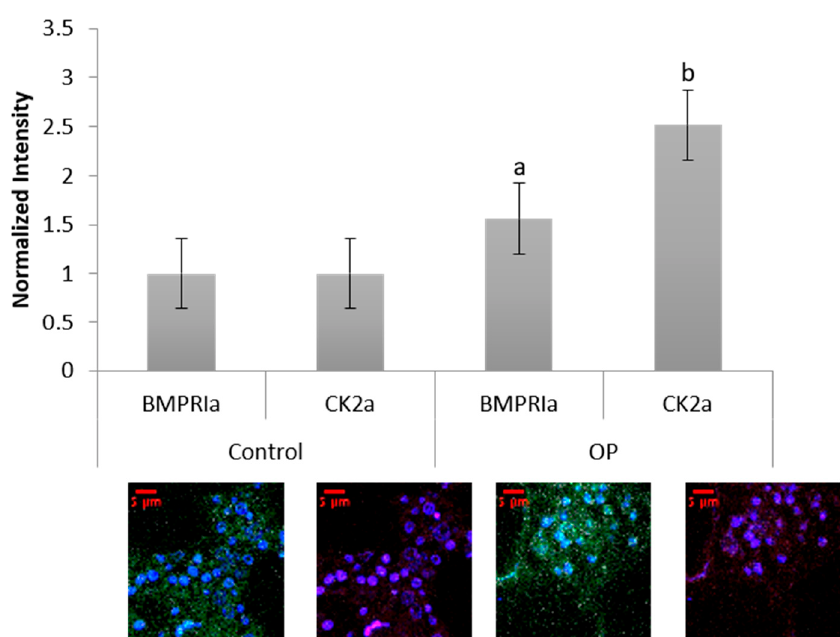
Figure 5. Female OP and OA (control) trabecular bone slices were embedded in MMA and fluorescently stained for BMPRIa (green), CK2 α (red), and the nucleus (blue). OP BMPRIa and CK2 α expression was significantly higher than the expression levels in control bone slices. Error bars represent standard error of the mean (SEM). “a” denotes statistically significant to control BMPRIa levels, “b” denotes statistically significant control CK2 α levels ( p < 0.05).